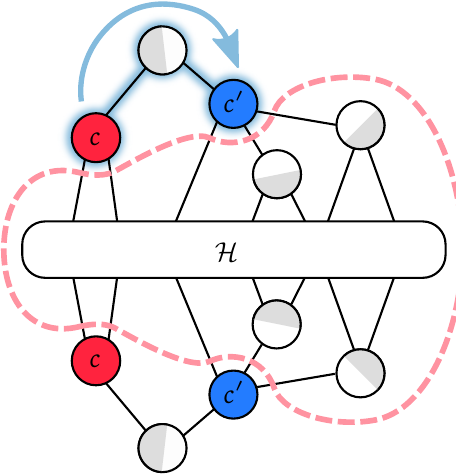
Figure 44: Moving the effective Hamiltonian from an optimization center c to another optimization center c (cid:48) . Only the renormalized Hamiltonian terms (Eq. (70)) defined on the links located on the path from c to c (cid:48) have to be updated (blue shaded). All other renormalized Hamiltonian terms (contractions within the red-dashed area) are left unchanged by this move and therefore do not need to be